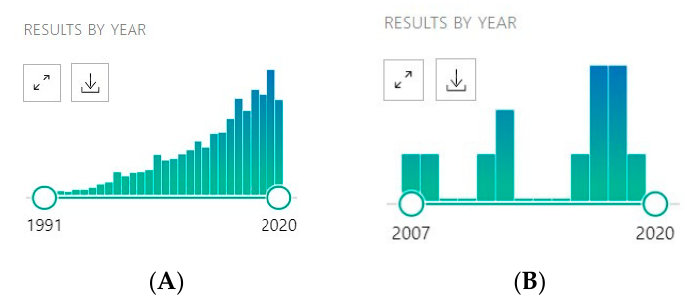
Figure 4. ( A )—Number of articles on PubMed: using the keywords “probiotic” and “yeast”, from 1995 to 2020. Data retrieved from https://pubmed.ncbi.nlm.nih.gov/?term=probiotic+yeast ( B )—Number of articles on PubMed: using the keywords “probiotic” and “yeast” and “wine”, data retrieved from https://pubmed.ncbi.nlm.nih.gov/?term=probiotic+yeast+wine. Accessed 23 September